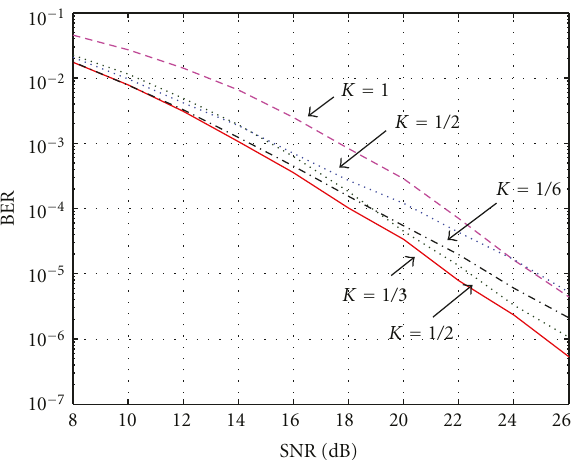
Figure 5: BER performance comparison for di ff erent SNR thresh- olds when R = 3: with relaying link selection.